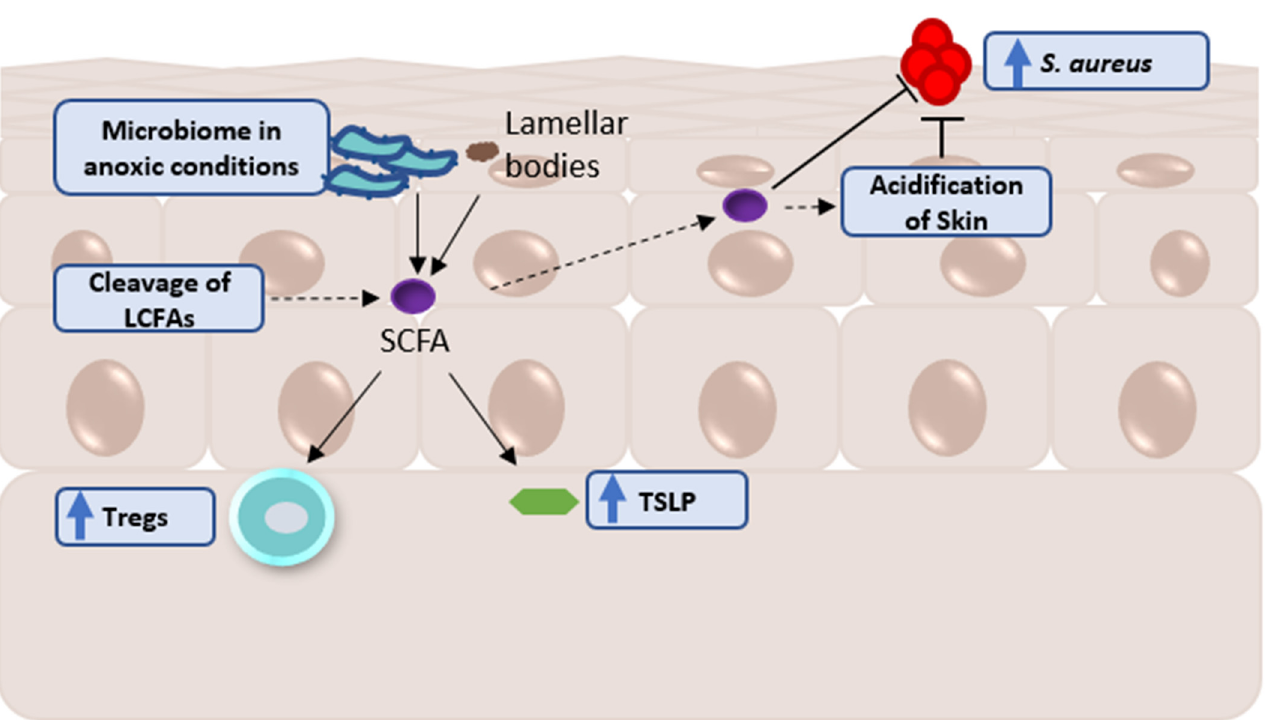
Figure 2. Diagram of shorter-chain free fatty acids (SCFA) within atopic eczema. Free fatty acids are produced from the breakdown of the lamellar bodies [81,82], and the lysis of the skin’s proteins and sebum by Cutibacterium acnes [83,84], and a select few are produced by the microbiome under anoxic conditions by the fermentation of carbohydrates [85–89]. These free fatty acids contribute to the acidification of the skin, which in healthy individuals is around 4.7 [90]. This acidification discourages S. aureus growth, and the production of SCFAs inhibit the other growth of pathogenic sub-strains [79]. Resident skin bacteria can also use the SCFAs to interact with the host’s immune system through inducing T regulator cells (Tregs)—by decreasing the transcription of il6 —and TSLP [91–94]. Studies in other organs suggest that SCFAs can inhibit dendritic cells’ expression of lipopolysaccharide- induced cytokines (IL-6 and IL-12p40) [95] and activate macrophages, neutrophils, and monocytes through the G-protein-coupled receptor FFAR2 [96]. Although well studied in other organ systems, the SCFAs’ mode of action in the skin is still unclear. Symbol: ↑ (increase) and a dotted arrow (theoretical mechanism). Table 2. Overview of adult metabolite profiles according to established AE endotypes. Abbrevi- ations: u.s (unstudied). The upward arrow ( ↑ ) indicates an increase in the metabolite relative to the first category and the downward arrow indicates a decrease ( ↓ ) in the metabolite relative to the first category.